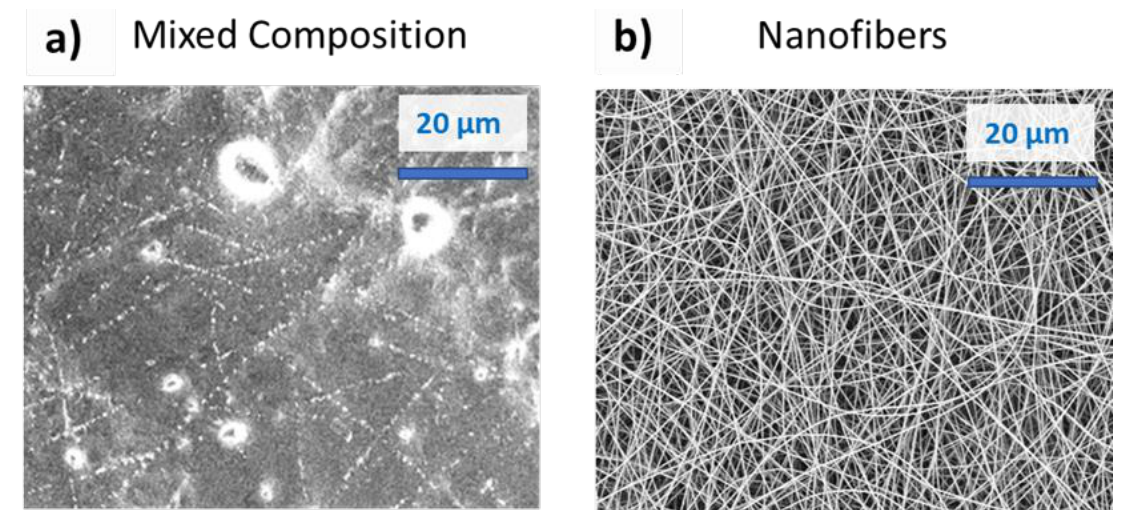
Figure 4. ( a ) FESEM of the PEO/PEDOT:PSS MC (electrospun nanofibers immersed in a film-like structure) and ( b ) FESEM of the PEO/PEDOT:PSS NFs.